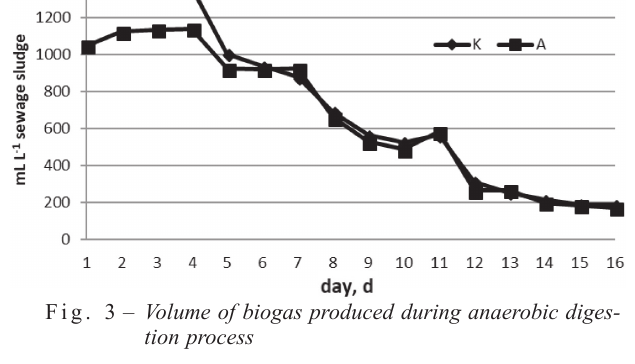
Table 4 – Parameters of co-digestion